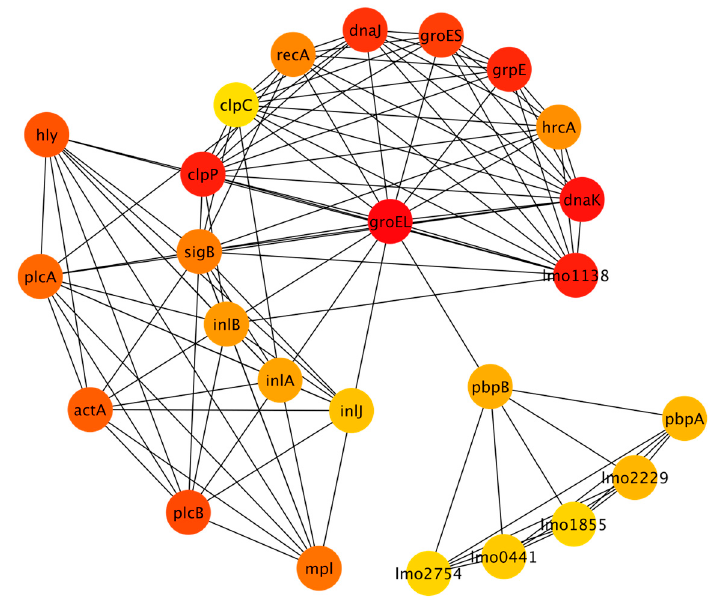
Figure 2. Stress response network depicting top 25 nodes (refer to Table S1 for additional information about each